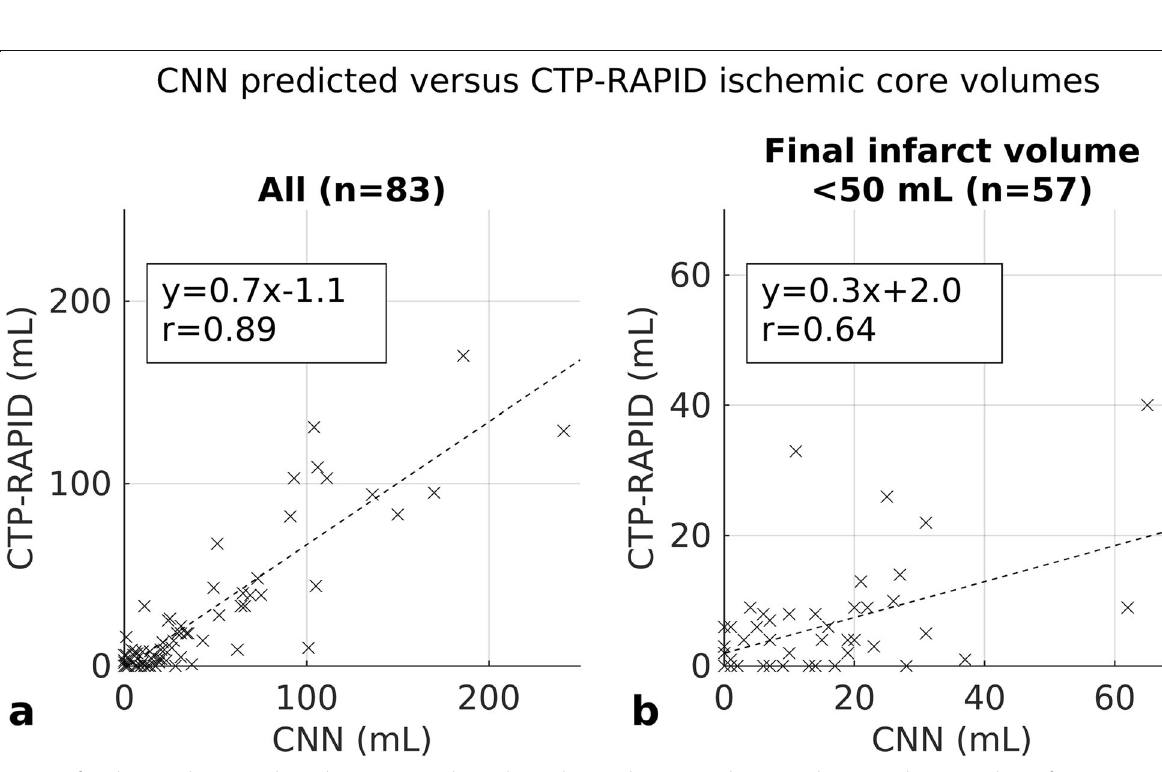
Fig. 7 Infarct lesion volume correlation between convolutional neural network (CNN) predictions and computed tomography perfusion RAPID (CTP-RAPID) ischaemic core (cerebral blood flow, CBF < 30%). All cases ( a ). Patients with final infarct volume less than 50 mL ( b